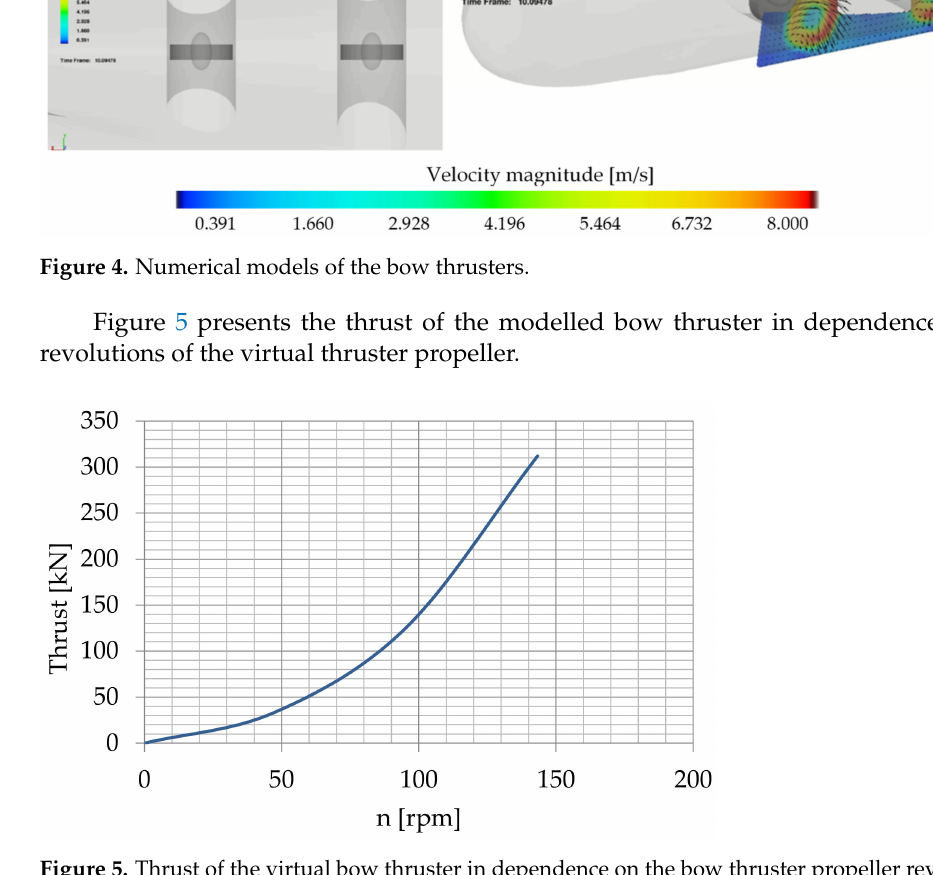
Figure 5. Thrust of the virtual bow thruster in dependence on the bow thruster propeller